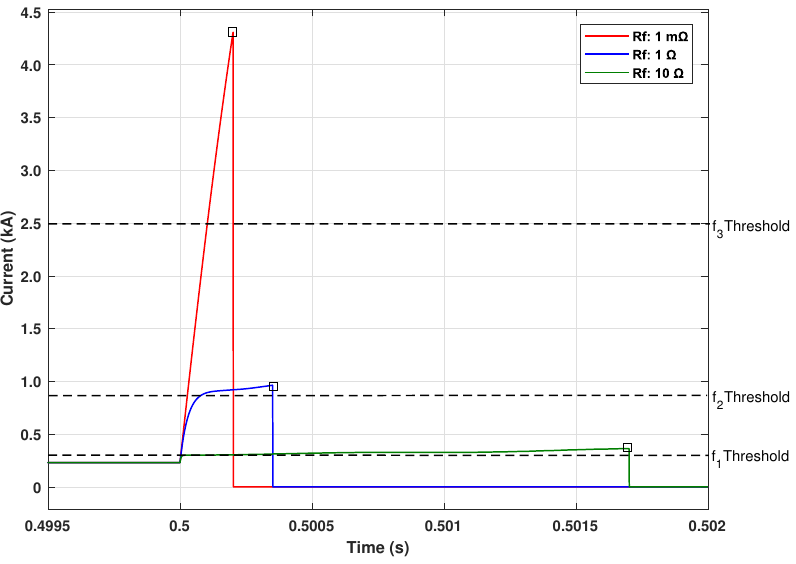
Figure 13. Interrupted fault currents comparison for the faults at F 1 having fault resistances of 1 m Ω , 1 Ω , and 10 Ω